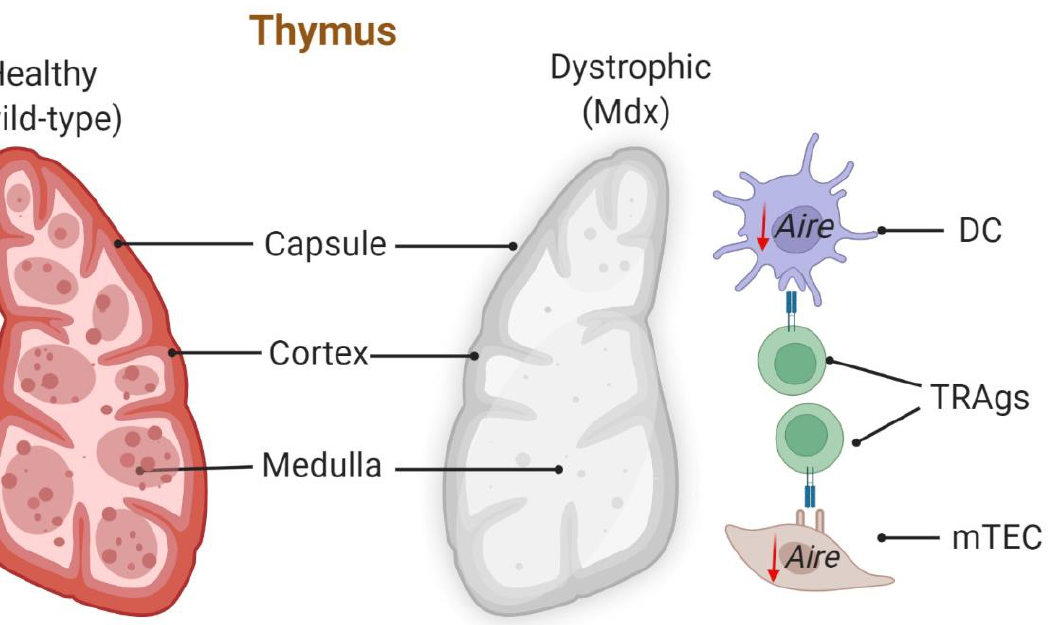
Figure 1. Architecture of thymus is altered in mdx. Wild-type thymus shows well-organized lobules with clear cortex and medullary boundaries. Screening and deletion of potential auto-aggressive lymphocytes (expressing tissue-restricted antigens (TRAgs)) by dendritic cells (DCs) and medullary thymic epithelial cells (mTECs) is under the control of autoimmune regulator (AIRE). In the mdx thymus, the architecture of the thymus is altered, evident by disorganized lobules with unclear cortex and medullary boundaries. The mdx thymus also has reduced medullary thymic epithelial cells (mTECs) and reduced expression of autoimmune regulator (AIRE) [26].